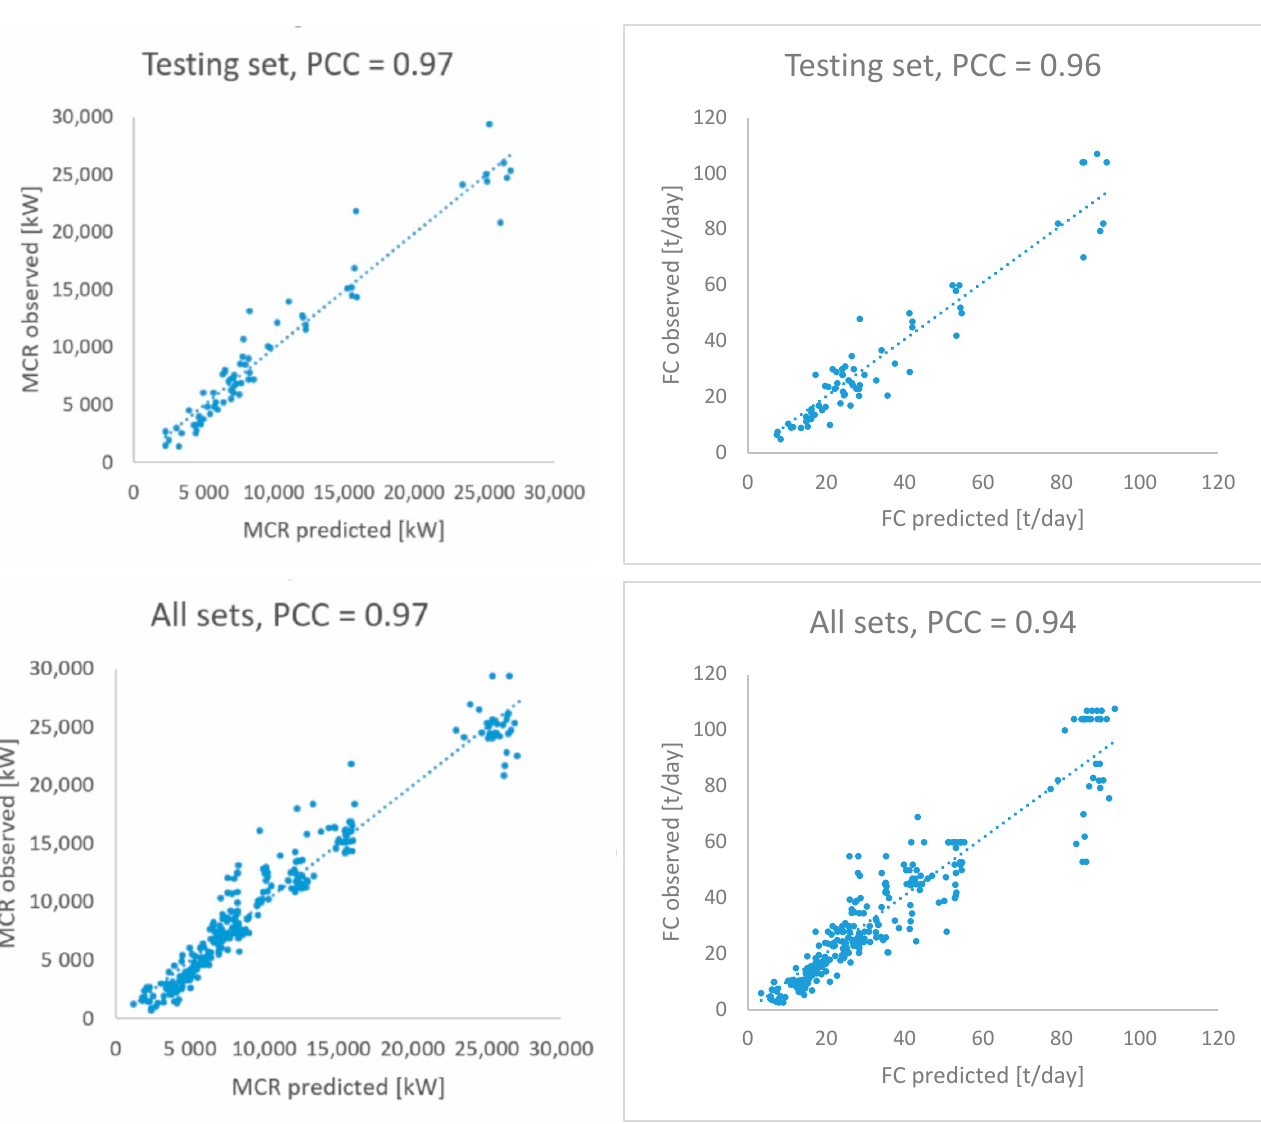
Figure 7. Regression graphs presenting the artificial neural network for estimating the engine power (MCR) and fuel consumption (FC) of tankers.